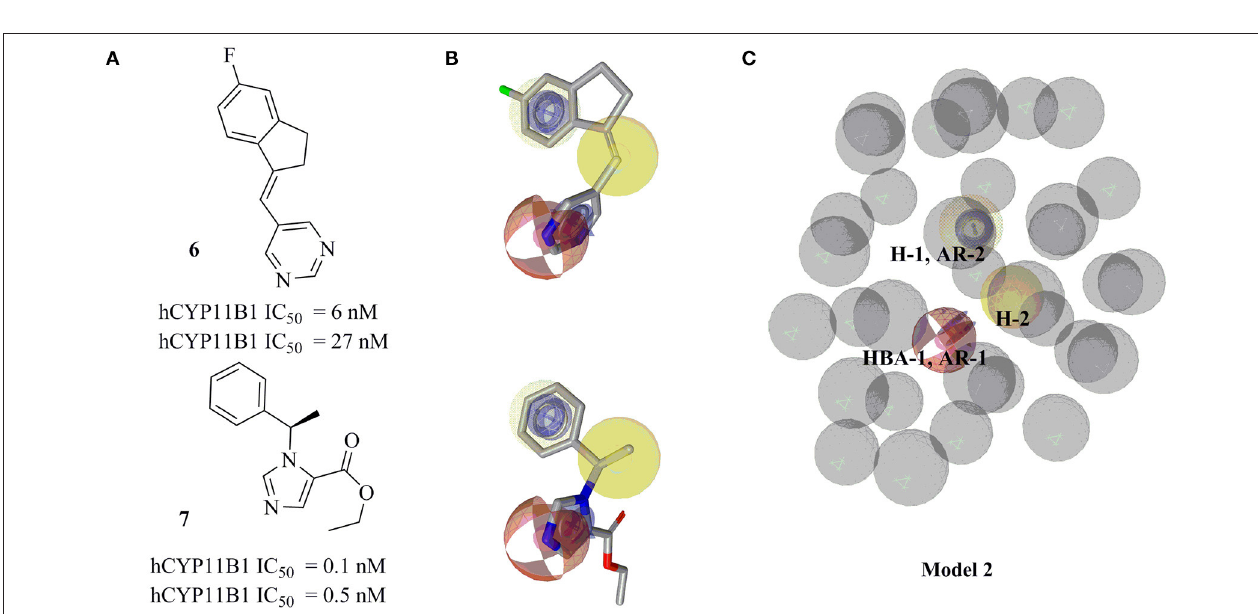
FIGURE 3 | Pharmacophore model 1 with training compounds 4 and 5 . (A) 2D training compounds with their IC 50 values are drawn. (B) Training compounds mapped into the model. (C) Final pharmacophore model 1 with color-coded features (yellow—hydrophobic, blue rings—AR, red—HBA, dotted style—optional features). The model consisted of 3 hydrophobic features, 3 HBAs, 2 AR features, and 47 XVOLs.